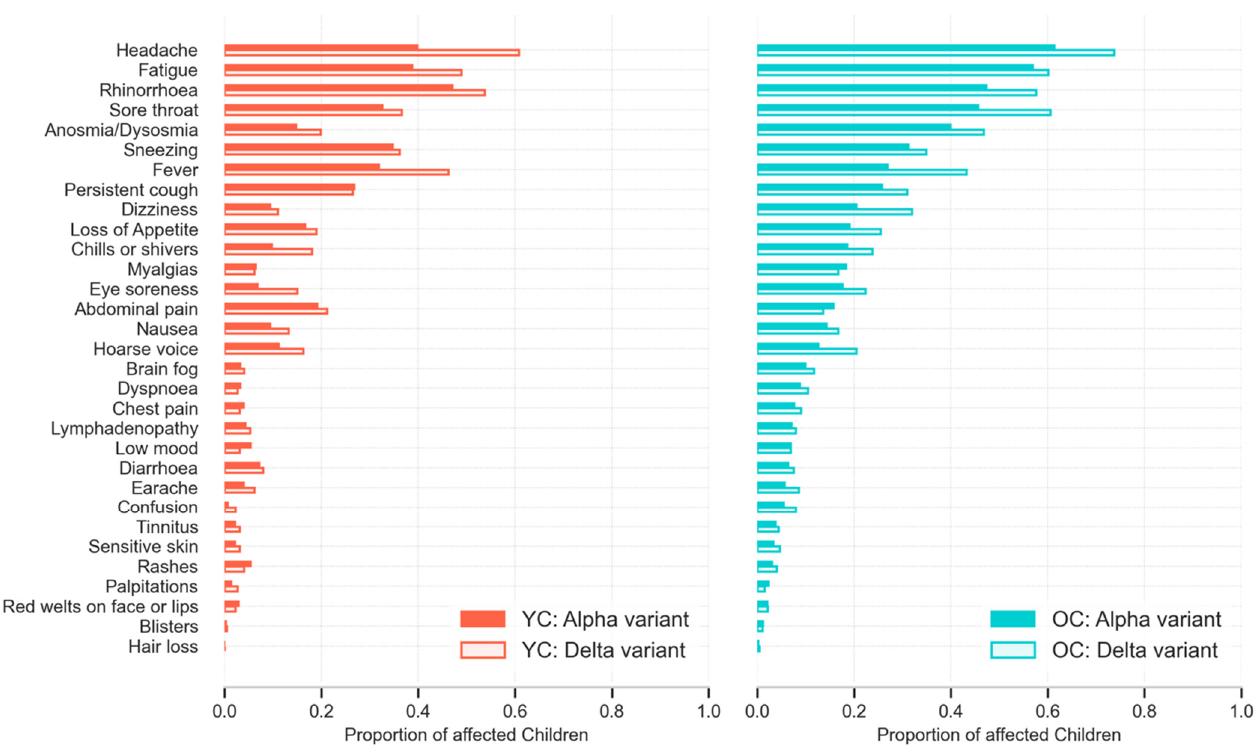
Figure 2. Prevalence of symptoms reported over the course of illness (up to 28 days) in younger (YC, 5–11 years) and older (OC, 12–17 years) children with COVID-19 during periods of SARS-CoV-2 Alpha or Delta variant predominance.